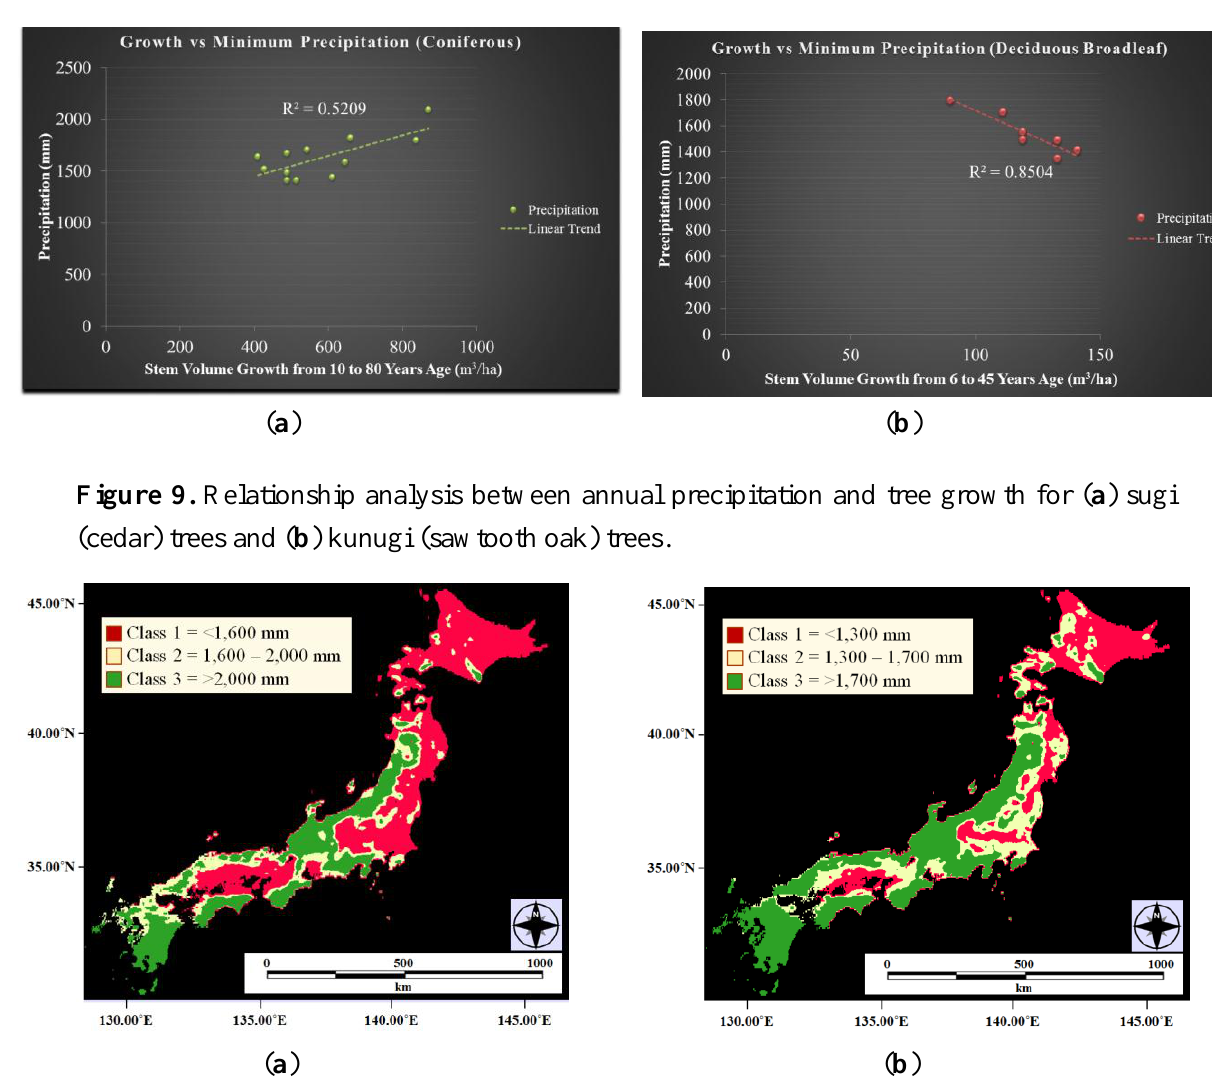
Figure 8. Mean growth curve of ( a ) coniferous and ( b ) deciduous broadleaf forests in each growth rate region, computed from the original Oita data.